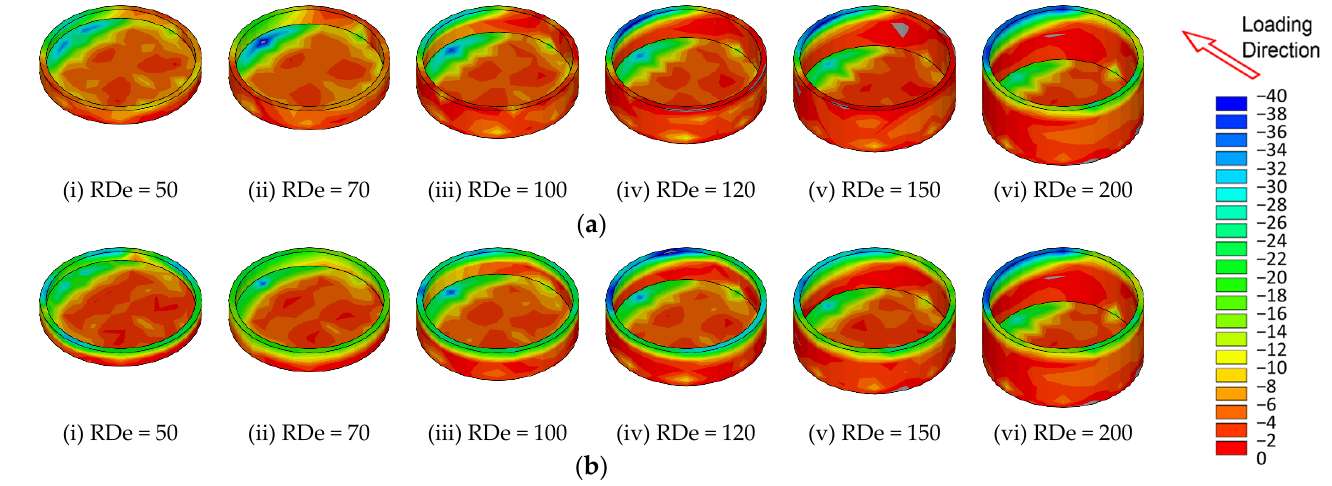
Figure 22. Mortar compressional stress with different recess depths (unit: MPa): ( a ) at the lateral displacement of 50 mm; ( b ) at the lateral displacement of 160 mm.